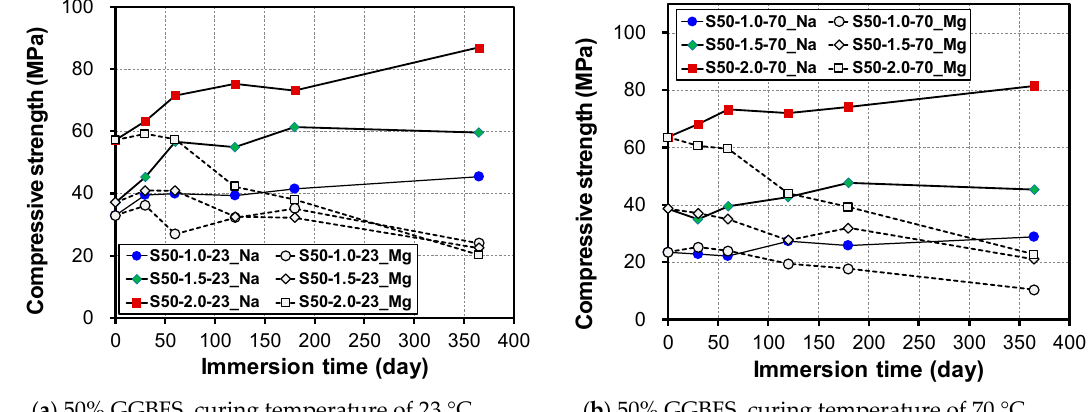
Figure 5. Change in compressive strength based on MS, sulfate solution type, and initial curing temperature at ( a ) 23 °C and ( b ) 70 °C.